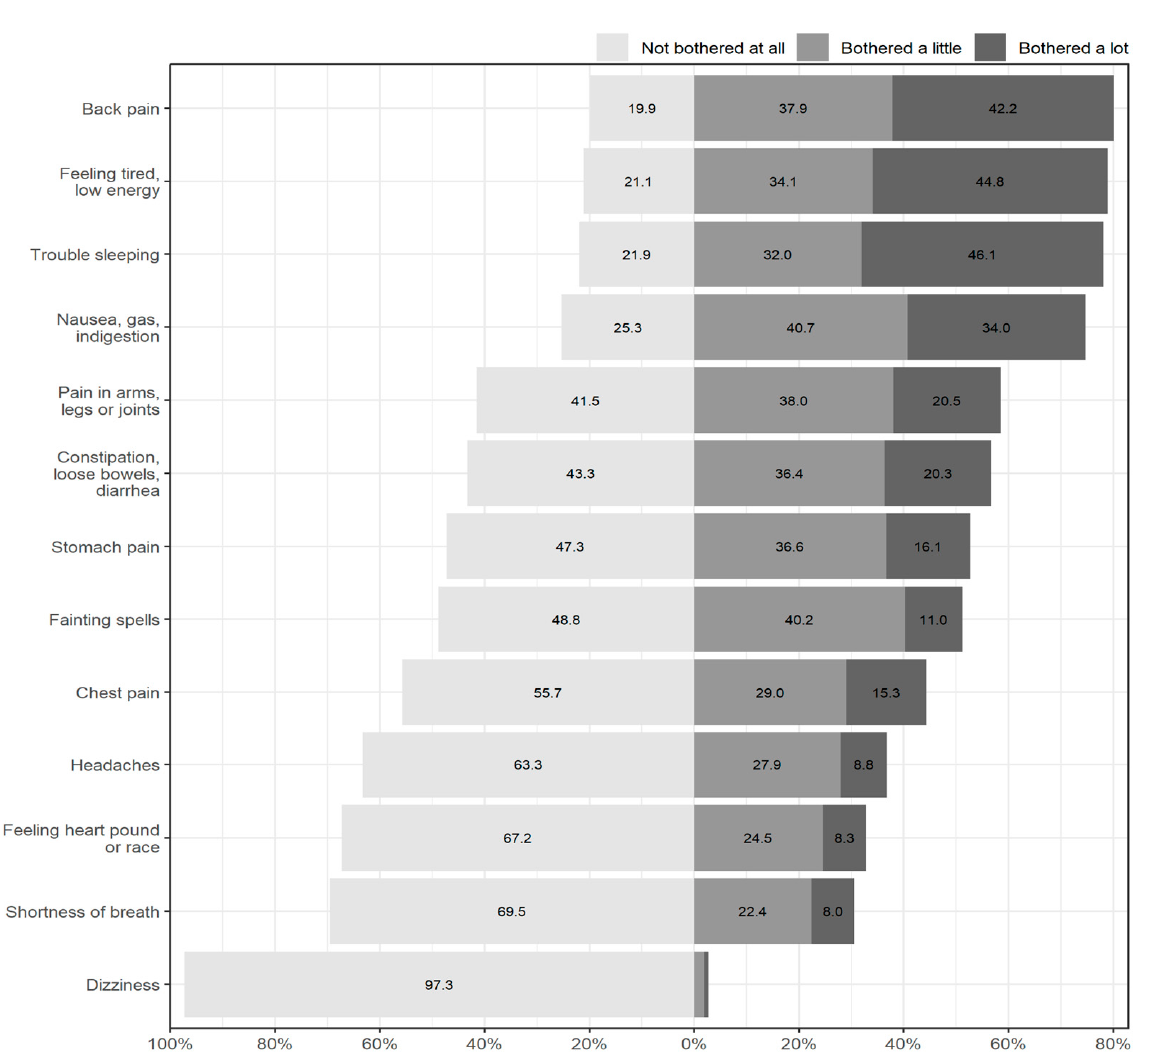
Figure 1. Prevalence of Somatic Symptoms.